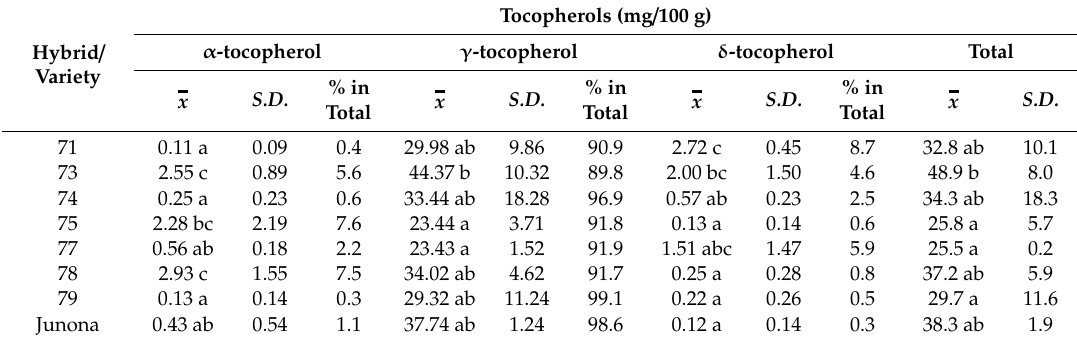
Table 3. Tocopherol content in the total content of lipids from seeds of studied Styrian oil pumpkins.